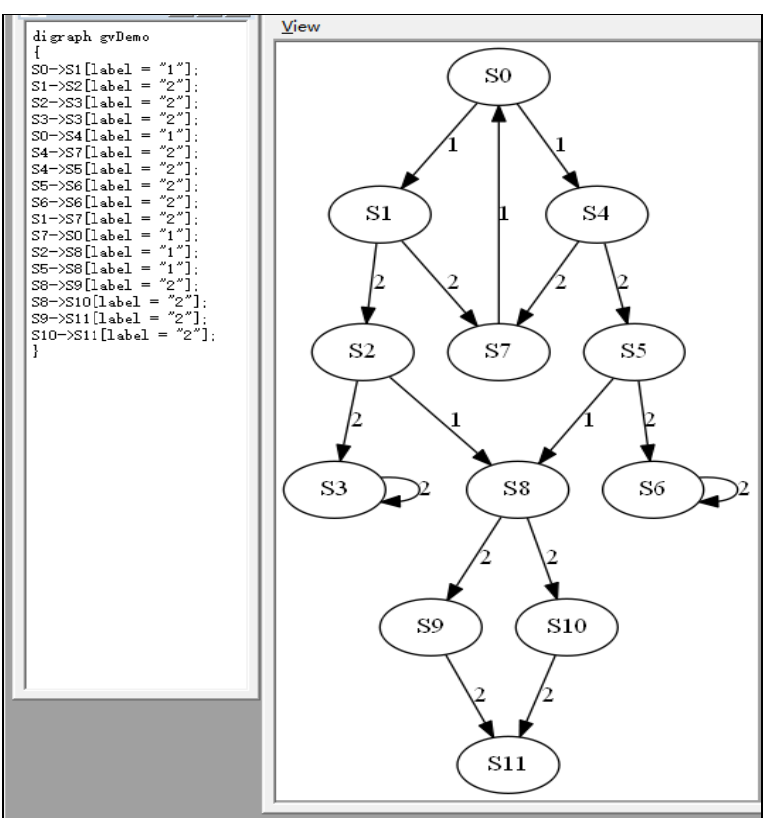
Figure 7. Service invocation diagram of client-side information reception module.